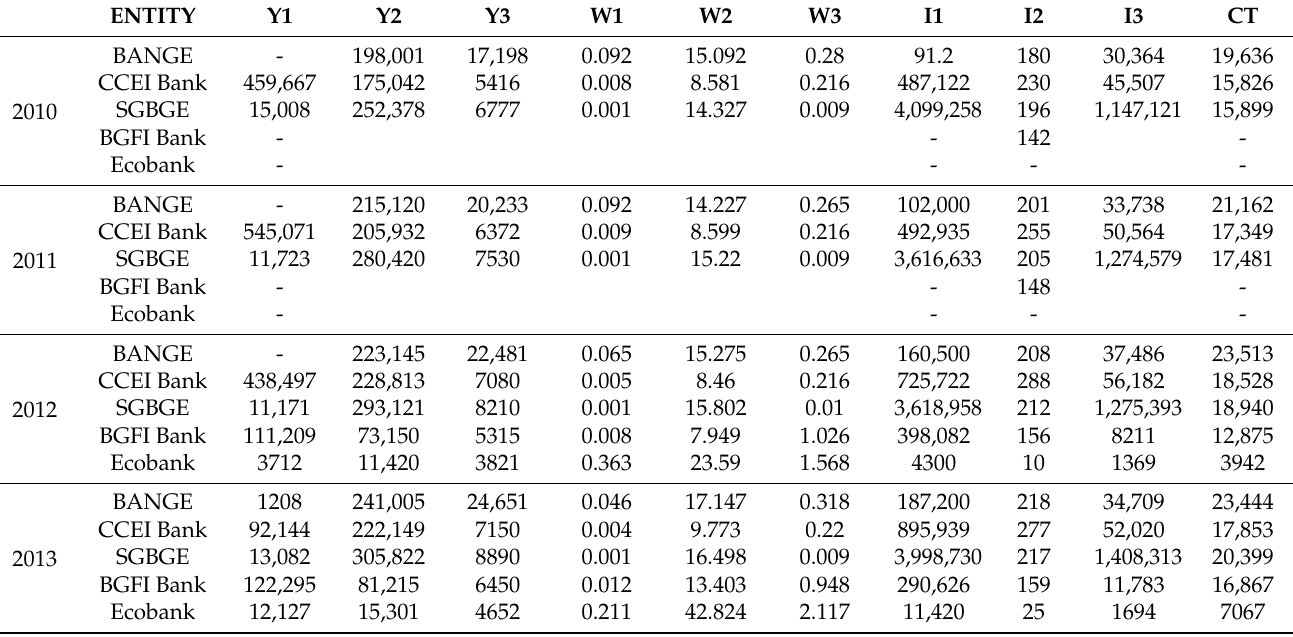
Table 2. Total costs, outputs, inputs and input prices for E.G. banks